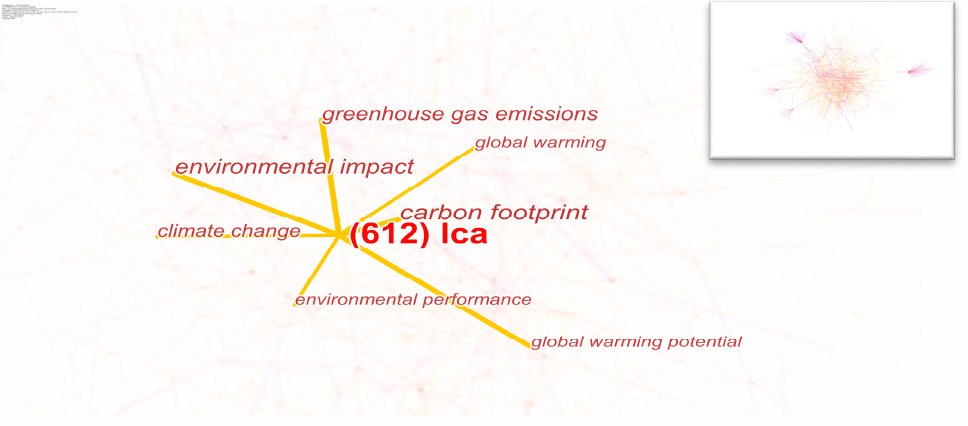
Figure 2. Life cycle assessment (LCA) in the whole noun term co-occurrence network.